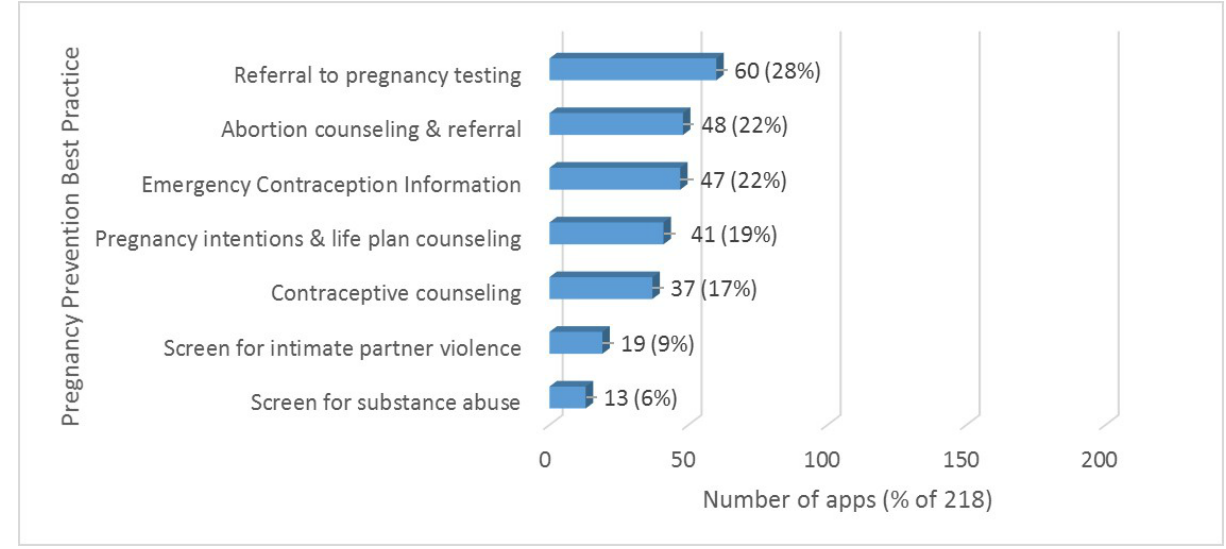
Figure 3. Pregnancy Prevention Best Practices Found in